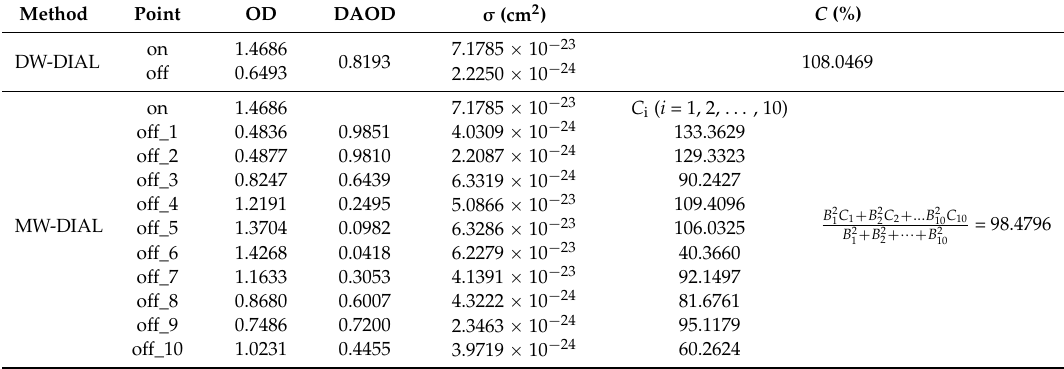
Table 8. Optical depths of different wavelengths and inversion results using the two